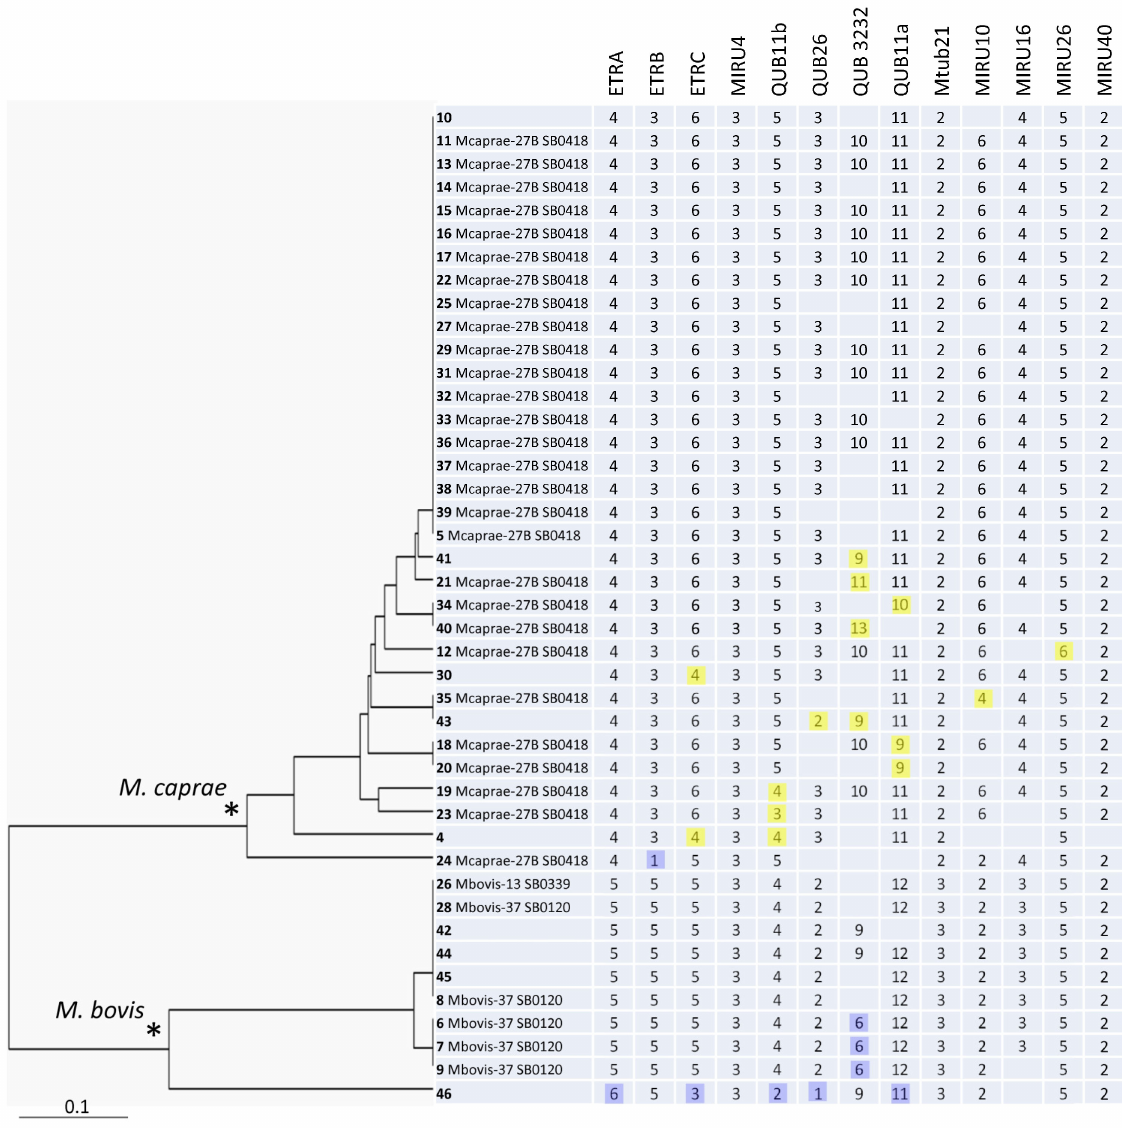
Figure 1. The 13-VNTR UPGMA tree of all 43 M. bovis isolates from Bulgaria. ID includes information on strain number (in bold), followed by the WGS-based group, and spoligotype number in Mbovis.org (if available). Minor alleles with regard to the main alleles in the branch ( M. bovis, blue, or M. caprae, yellow) are highlighted. * Two main branches of M. bovis and M. caprae are marked by